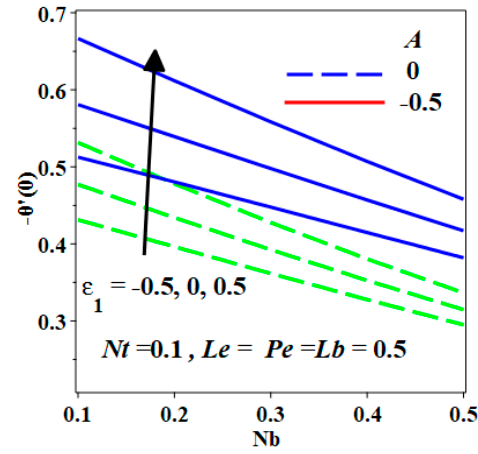
Figure 7. Variation of A , Nb and ε 1 on − θ (cid:48) ( 0 ) .